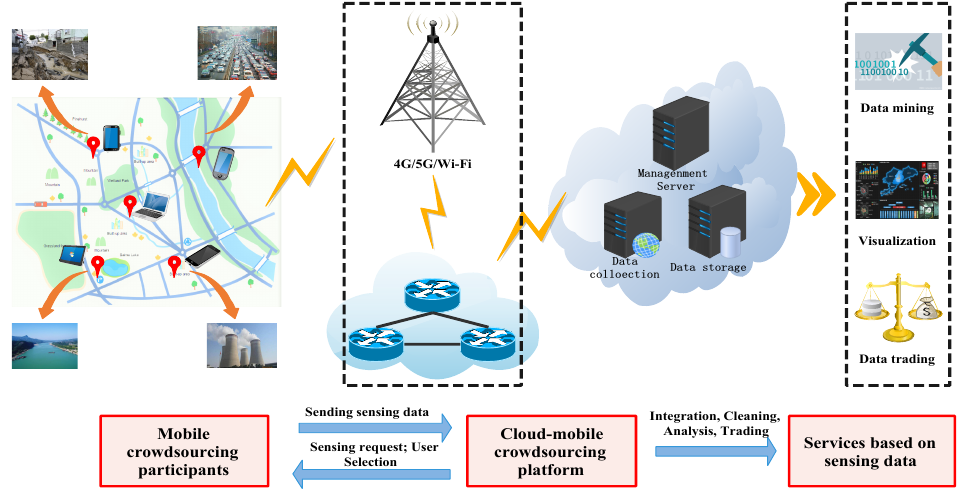
Figure 1. A mobile crowdsourcing